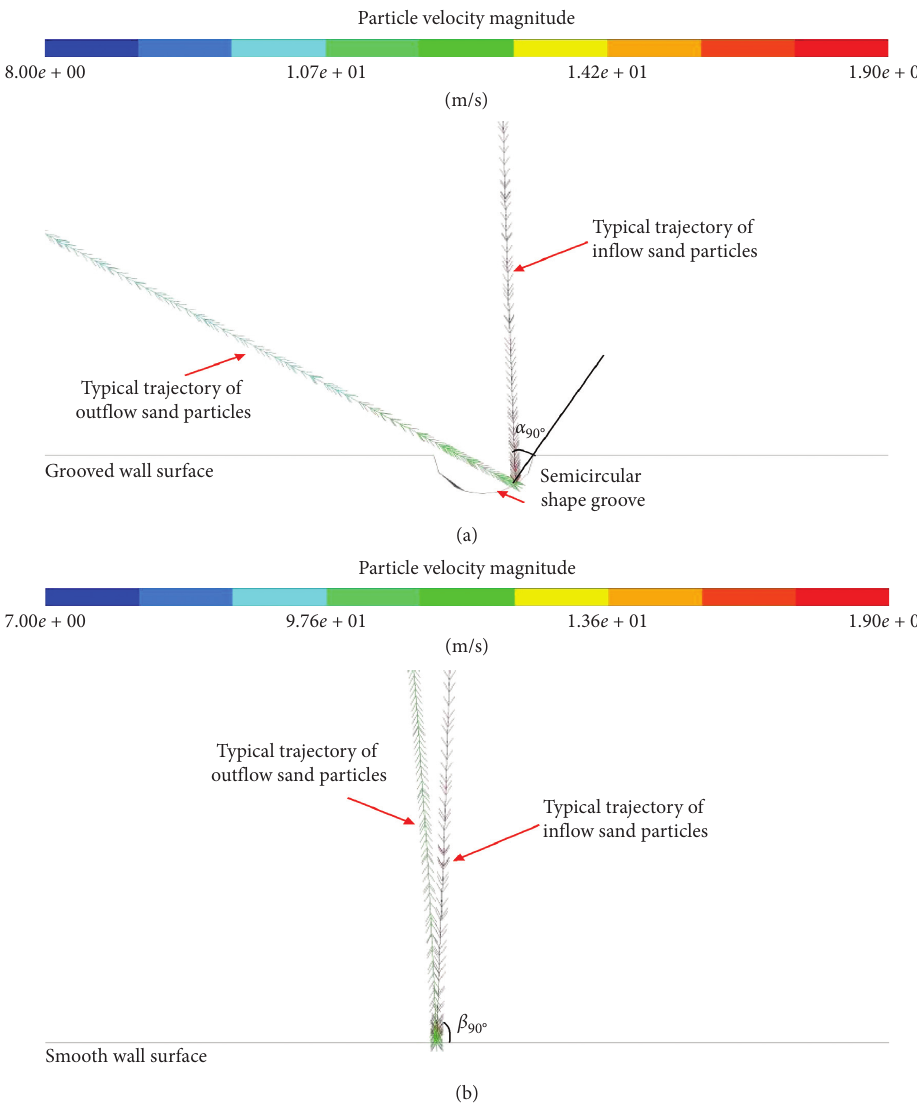
Figure 6: Typical trajectories of sand particles interaction with concrete wall surfaces at the impact angle of 90 ° and wind velocity of 19m/s: (a) grooved; (b)